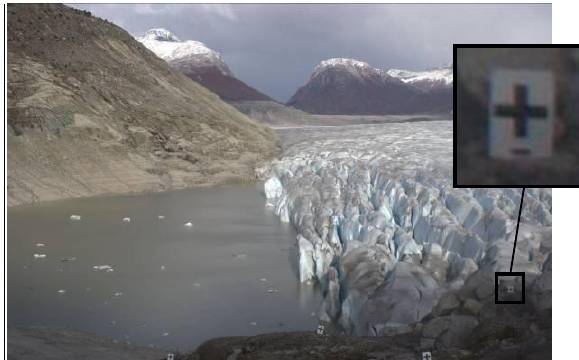
Figure 9. Image of sequence taken on Lago Nef Norte . In the foreground the fiducials are visible